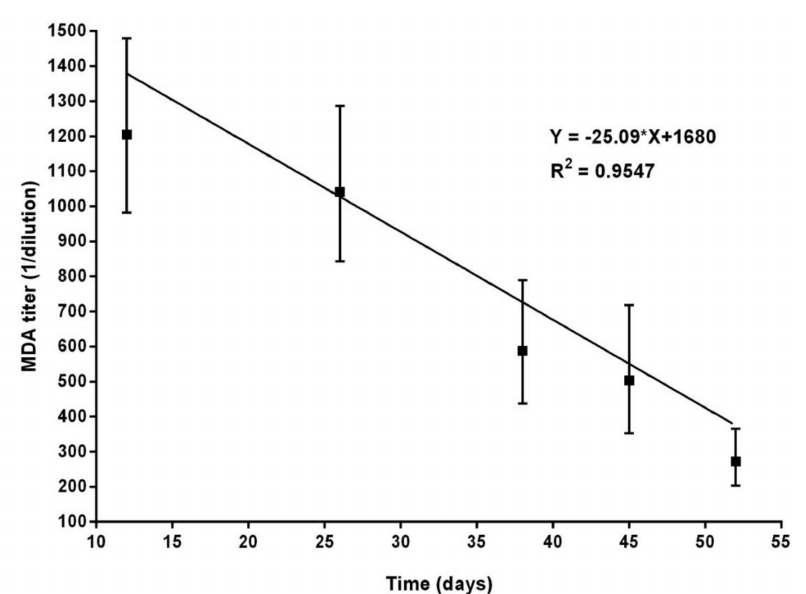
Figure 2. Serum NAb titers (MDA) in the offspring of two sows immunized with MLV and re-immunized with E2CD154. Sows received two injections of E2CD154 during the first trimester of pregnancy. Serum was collected on different days from twenty piglets and the NAb titers were measured by NPLA. The GM and the confidence intervals of MDA titers are represented. The study was conducted in swine under production conditions.